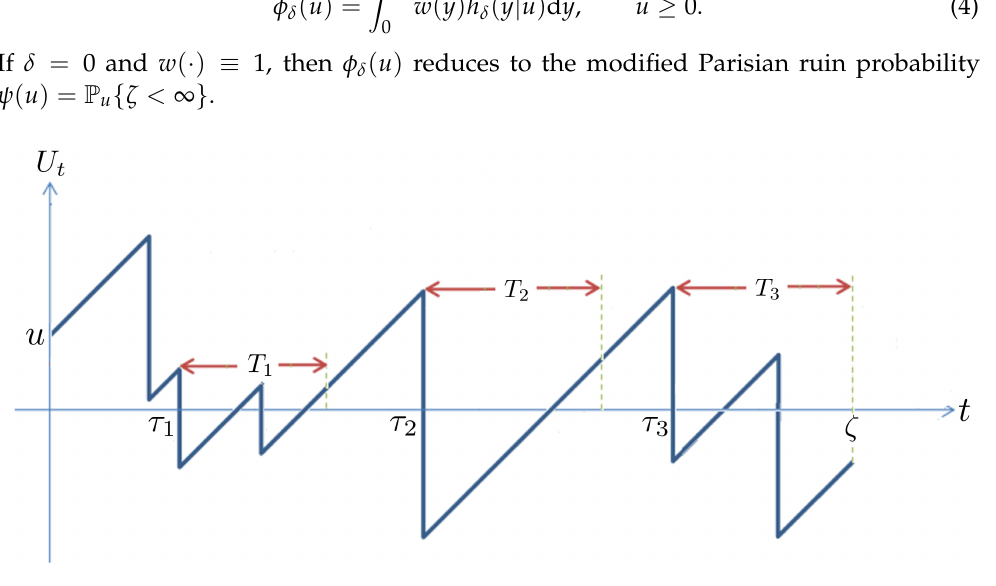
Figure 1. Sample path illustrating the construction of the modified Parisian ruin